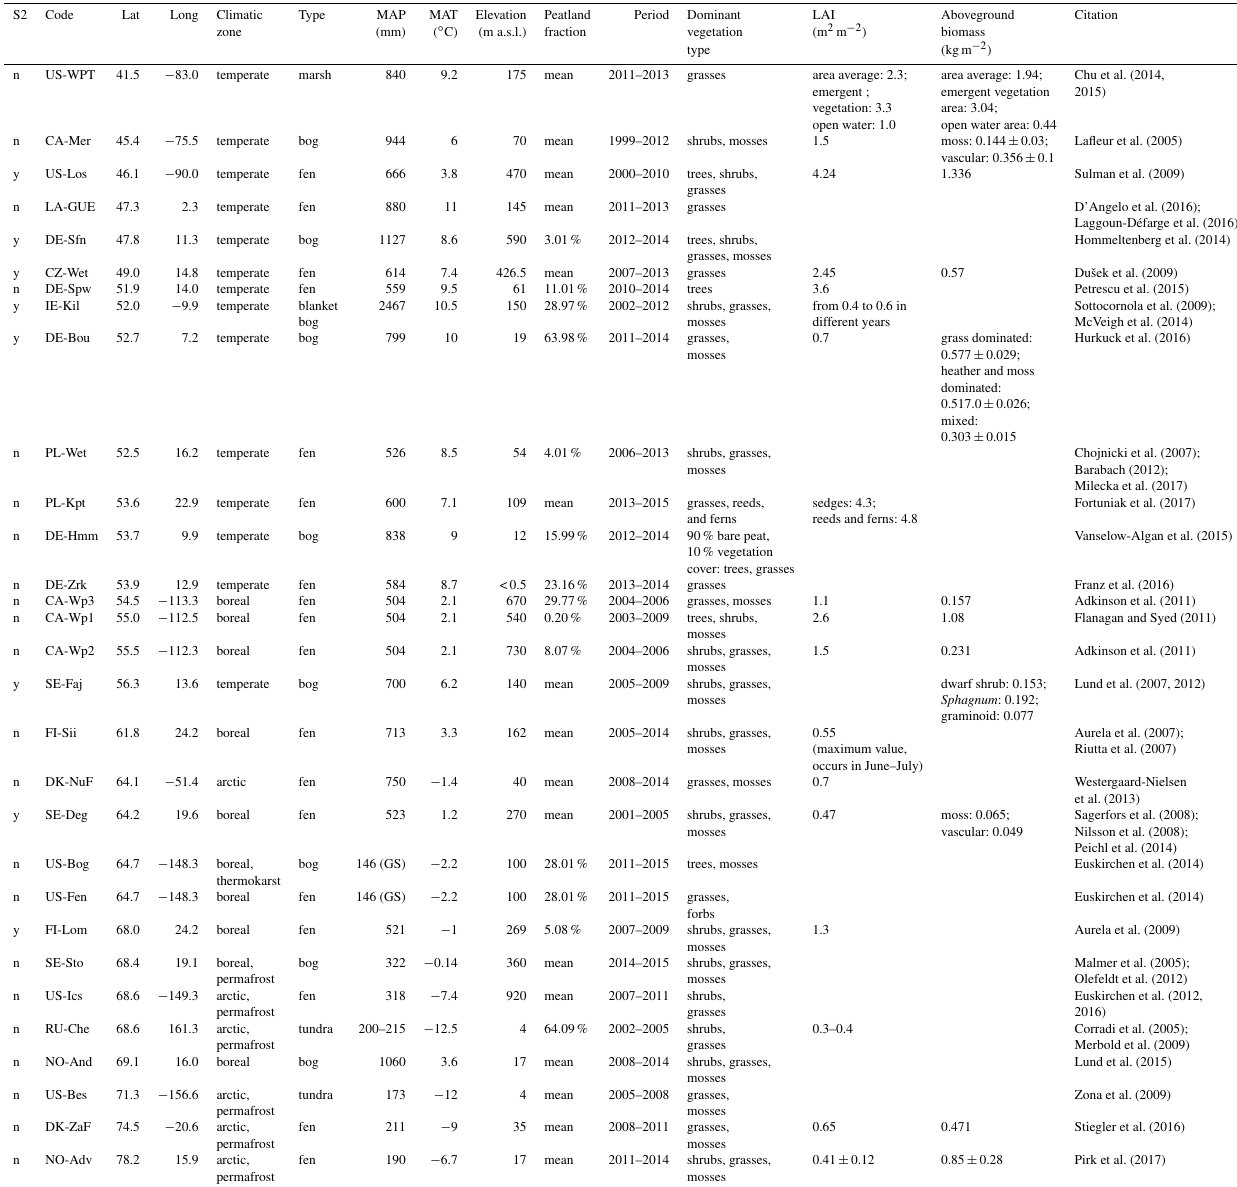
Table 2. Site characteristics of the 30 peatlands (sites are sorted by latitude from south to north). The first column denotes if the site is used in the second set of simulation (S2, with water table prescribed in the model equal to observed values): y – YES; n – NO. Lat: latitude; Long: longitude; MAT: long-term mean annual air temperature; MAP: long-term mean annual precipitation; peatland fraction (%): fraction of peatland in the 0.5 ◦ grid cell which is read from the map of Yu et al. (2010); for cells where there is no peatland, mean fraction (22%) is used. Note that, at US-Bog and US-Fen, the precipitation is the growing season (from 16 May to 31 August) mean value, thus clarified as “GS” in the table. Details of S2 and peatland fraction are provided in Sect.